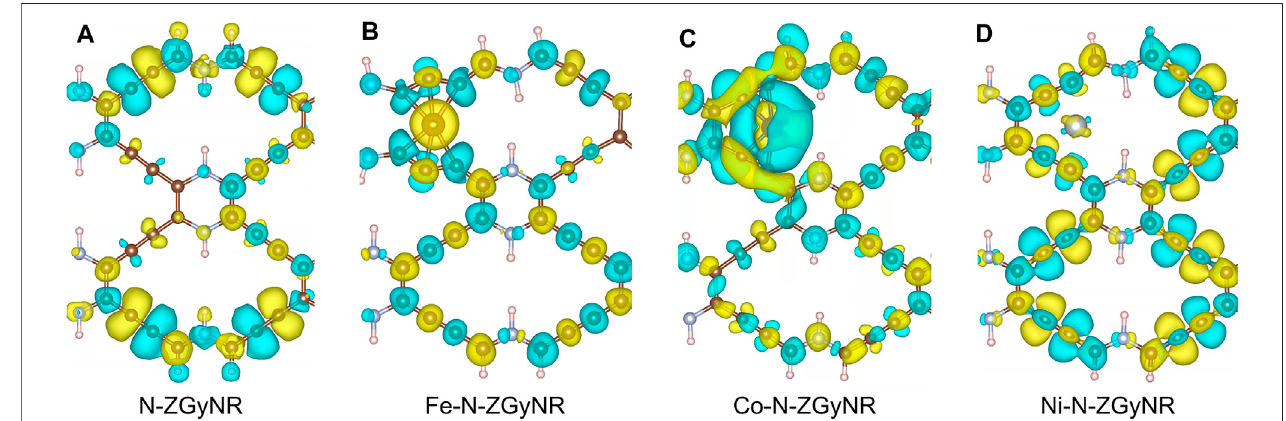
FIGURE3|(A – D) Thespinelectrondensityof(M-)N-ZGyNR(M=Fe,Co,Ni)respectively.Theelectronicmagneticmomentofspinup(spindown)isrepresentedby theyellow(lightblue)region.Tomakethecomparisonclear,theisosurfacelevelofN-ZGyNR,Fe-N-ZGyNR,Co-N-ZGyNRandNi-N-ZGyNRaresetto2×10 − 6 e/Å 3